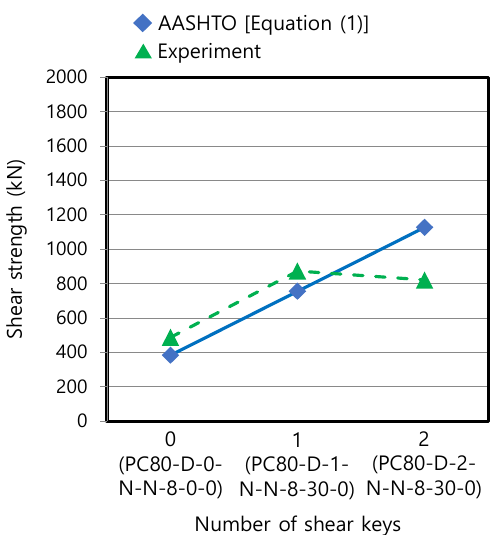
Figure 8. Comparison of test data with predictive equation of AASHTO [20] (dry joint without epoxy).